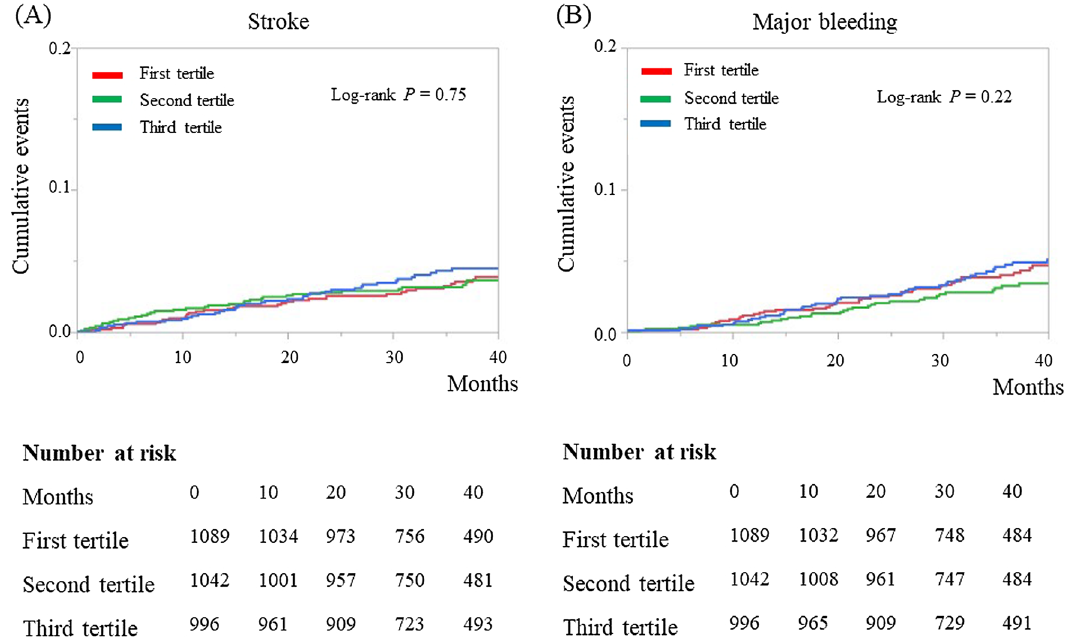
Figure 1. Kaplan–Meier curves for the incidence of stroke ( A ) and major bleeding ( B ) during the follow-up period according to the tertiles of baseline alanine aminotransferase values in patients with nonvalvular atrial fibrillation (n = 3156) in the SAKURA AF Registry.